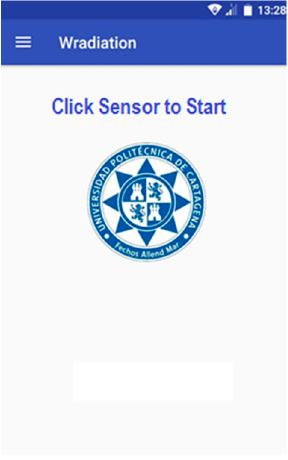
Figure 17. Main screen.